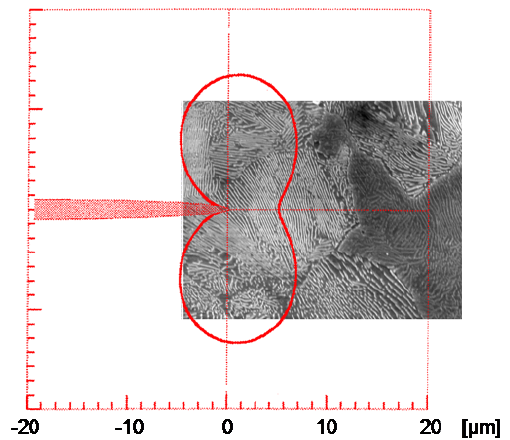
Figura 10: Zona plastica di fronte all’apice della cricca di fatica propagante attraverso colonie perlitiche a cuore di un blumo di acciaio 1.2738, temprato e rinvenuto. Sono presenti anche limitate zone di austenite residua e bainite modificate dal rinvenimento. Figure 10: Plastic zone at the fatigue crack tip propagating through a pearlite colony at the core of a 1.2738 steel quenched and tempered large bloom. Rare areas of bainite and residual austenite modified by tempering are also present.